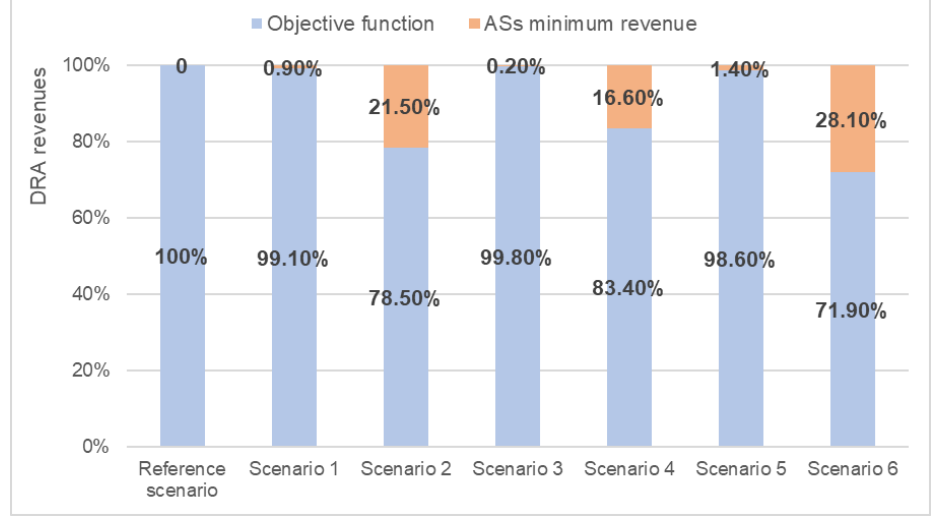
Figure 11. Minimum required revenues from the ancillary service (AS) provision for each scenario.